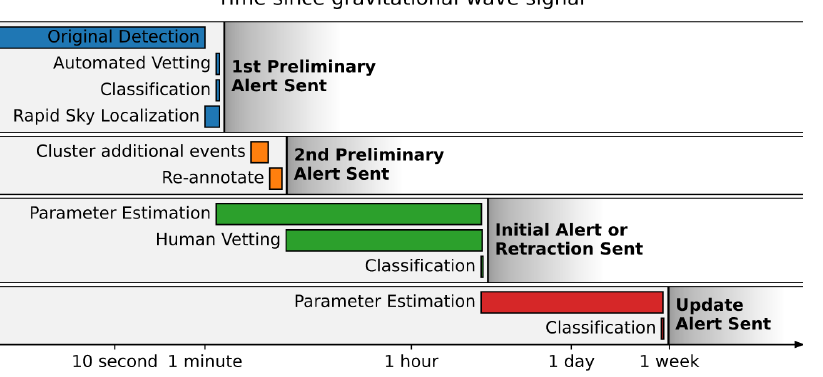
Figure 11. Alert timeline for O3. Image credit: Public alerts User Guide, https://emfollow.docs.ligo. org/userguide/index.html (accessed on 10 August